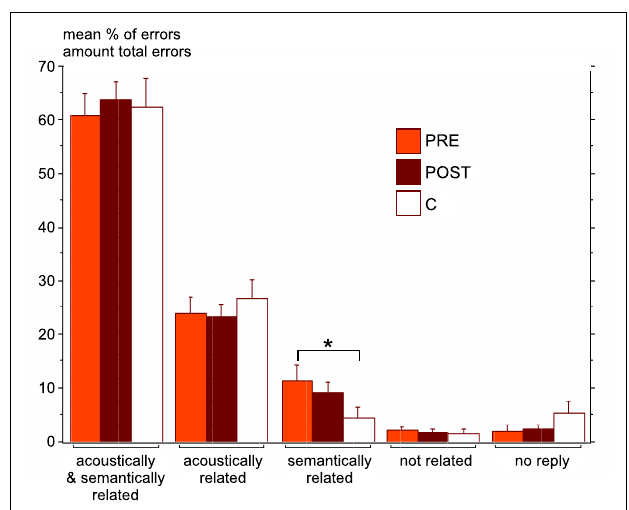
FIGURE 5 | Mean percentage and standard error of the different types of incorrect responses in the semantic identifi cation test, in each group (PRE in orange, POST in brown and C in white). Errors could be either acoustically and semantically related to the correct answer, or only acoustically related, or only semantically related, or not related at all, or due to an absence of response. The only signifi cant difference between groups (Mann–Whitney tests) is indicated (* P < 0.05). C, control group ( n = 18); PRE, preoperatively tested patient group ( n = 11); POST, postoperatively tested patient group ( n =